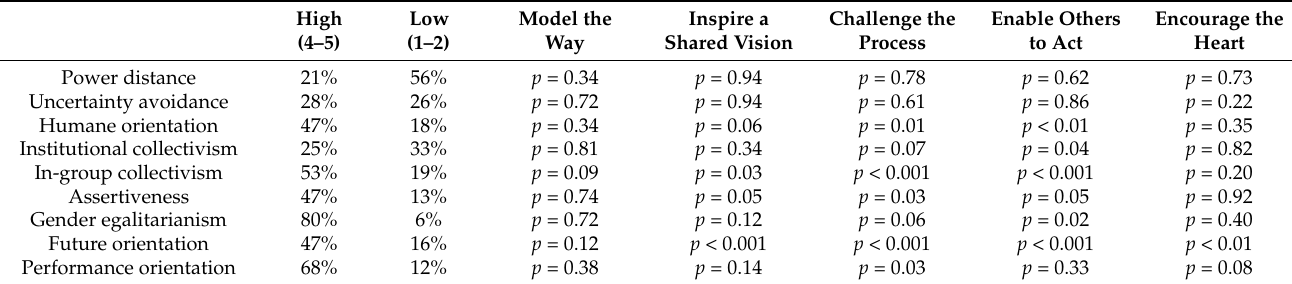
Table 8. Impact of cultural dimensions on importance (high scores vs. low scores).